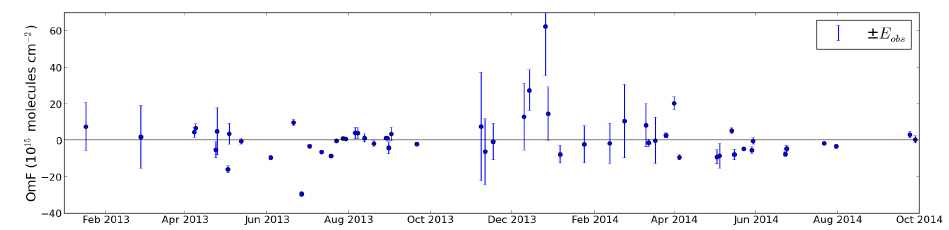
Figure 4. The time series of the OmF from January 2013 to September 2014 for the single grid cell over the center of Nanjing. The error bar is the root mean square error of observations ( E obs )